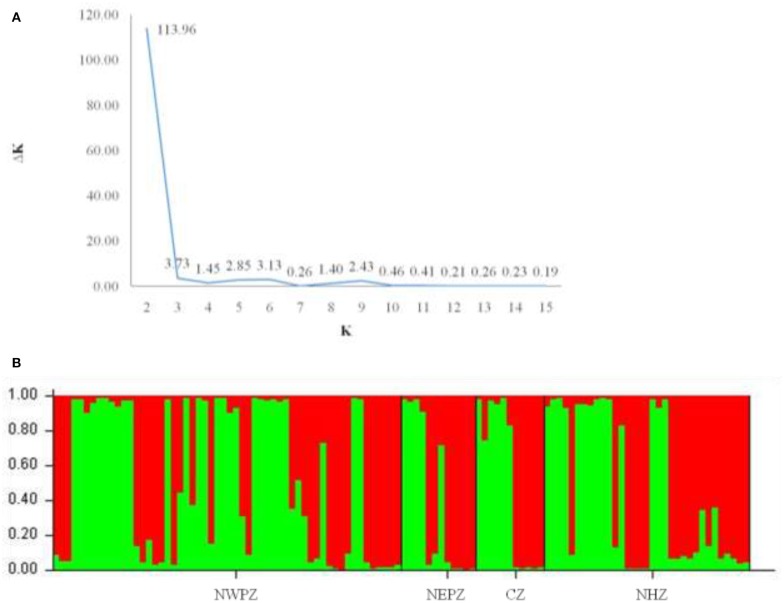
Cluster analyses of UST populations from four different wheat growing zones of India (results from Structure v2.2). (A) Each isolate is represented by a bar, divided into K colors, where K = 2 is the number of clusters assumed. Individuals are sorted according to Q, the inferred clusters; (B) Magnitude of ΔK calculated for each level of K. Maximum ΔK indicates the most likely number of UST populations (K = 2).